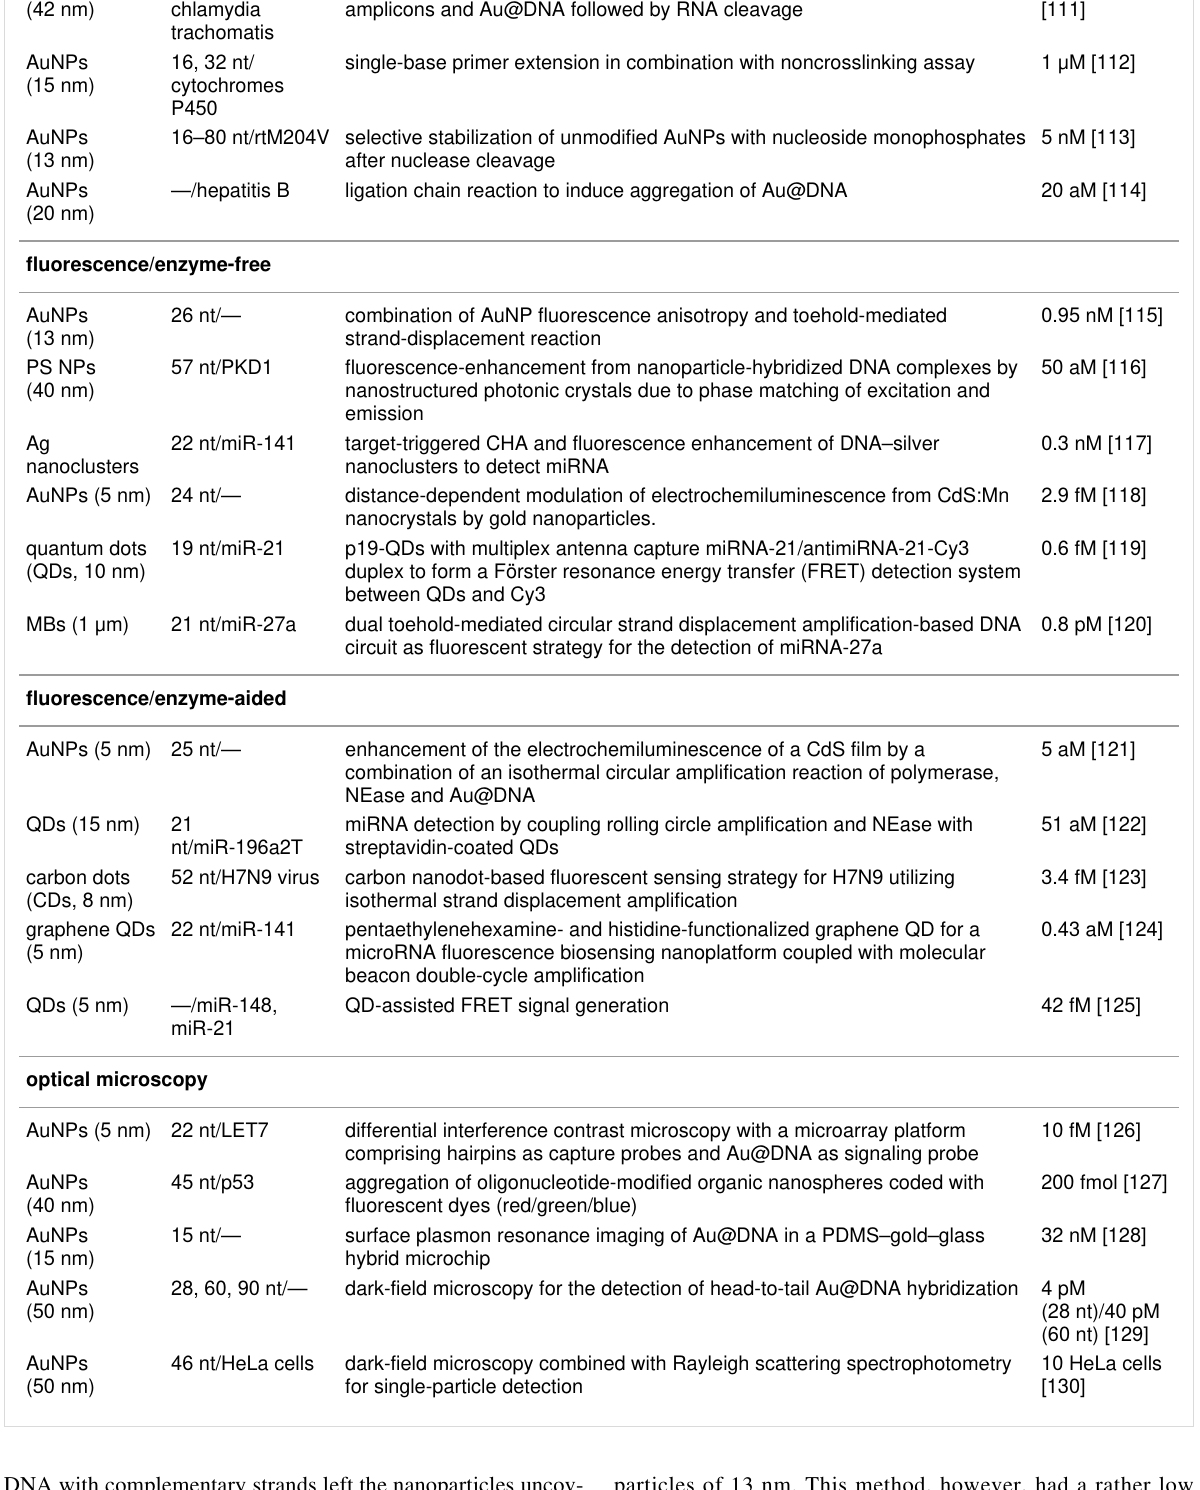
DNA with complementary strands left the nanoparticles uncov- ered, facilitating aggregation. The authors were able to detect single-base mismatches at the level of 43 nM using gold nano-